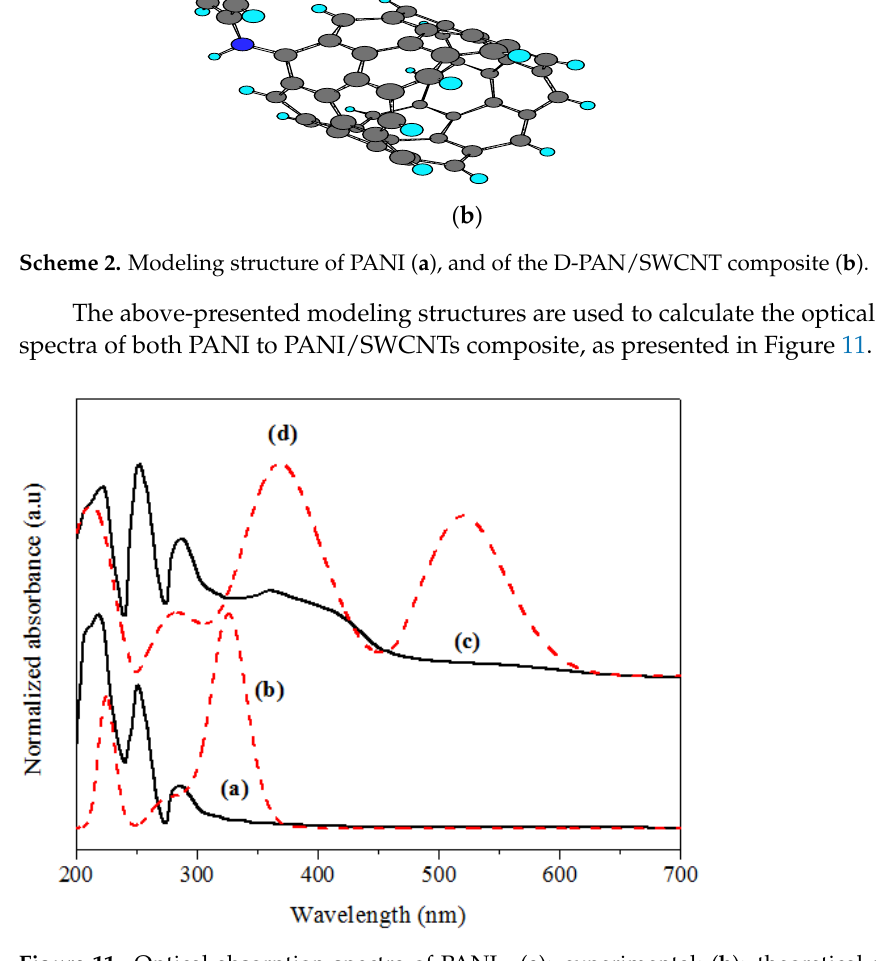
Figure 11. Optical absorption spectra of PANI—( a ): experimental; ( b ): theoretical and those of doped-Pani/SWCNTs nano-composite; ( c ): experimental; ( d ): theoretical.